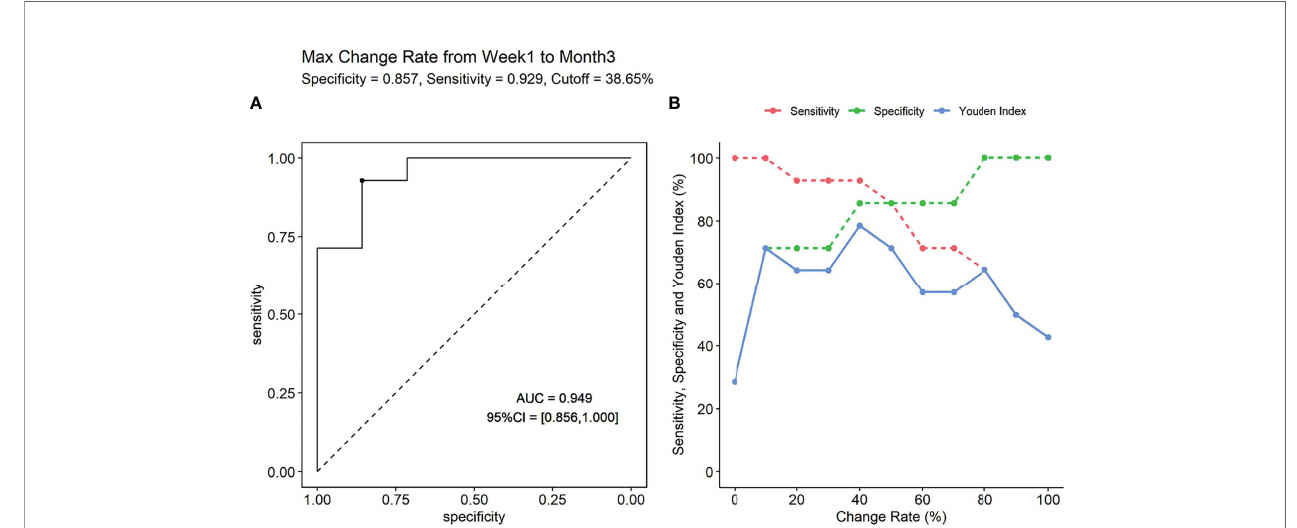
FIGURE 7 | The predictive performance of max change rate from the fi rst week to the third month for the occurrence of donor-speci fi c antibody (DSA). (A) The receiver operating characteristic (ROC) curve (if the max change rate is 38.65%, the Youden index is maximal). (B) The sensitivity, speci fi city, and Youden index were presented according to speci fi c change rate threshold.